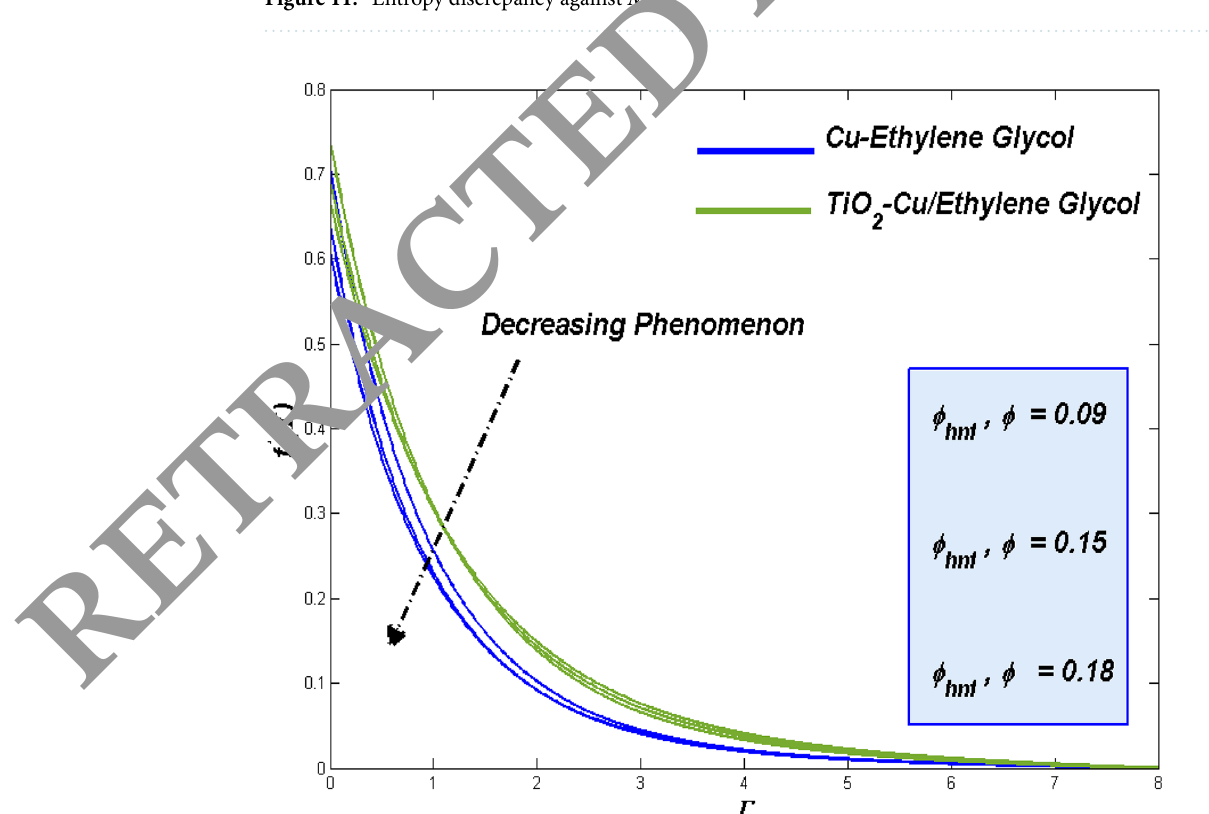
Figure 11. Entropy discrepancy against M .